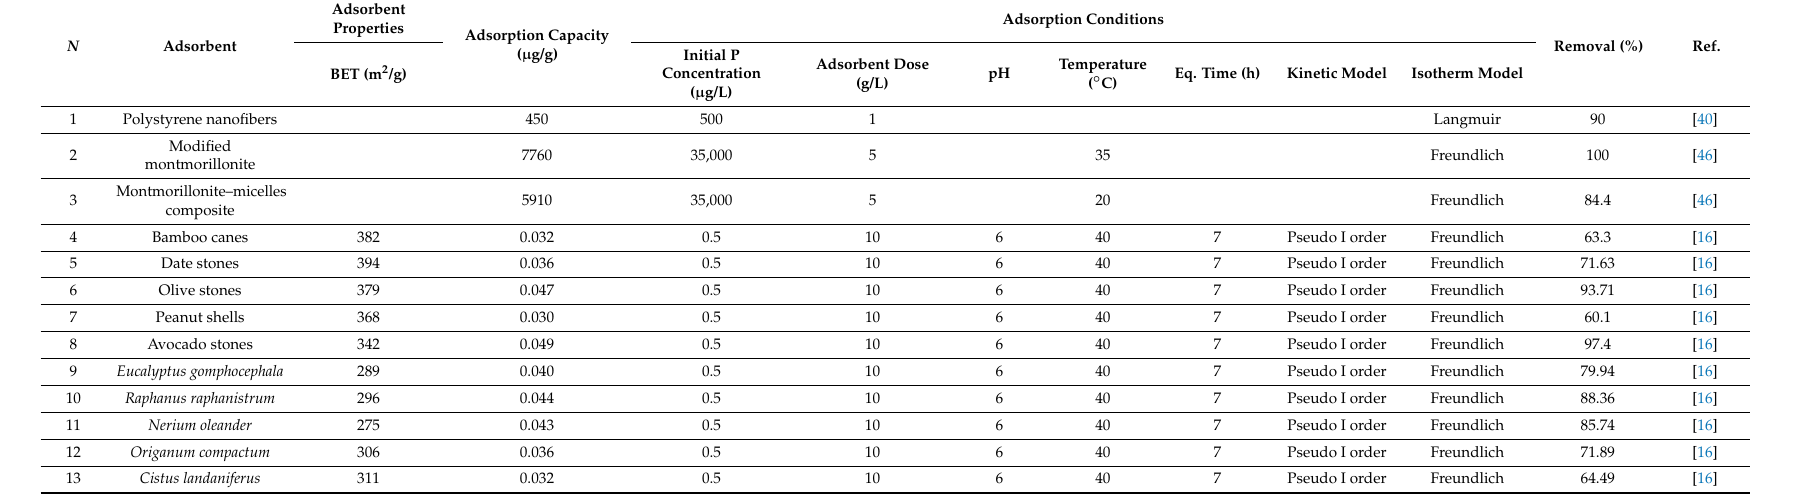
Table 5. Nanofibrous adsorbent properties and adsorption conditions for the removal of